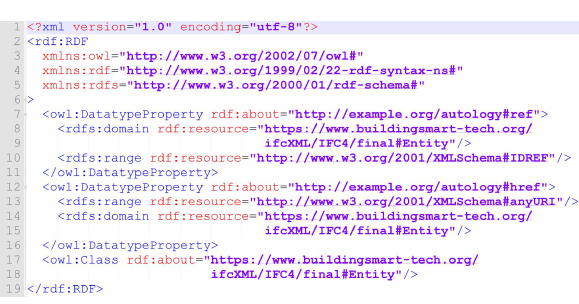
Table 2. Pertinent Patterns algorithm resulting PP matrix